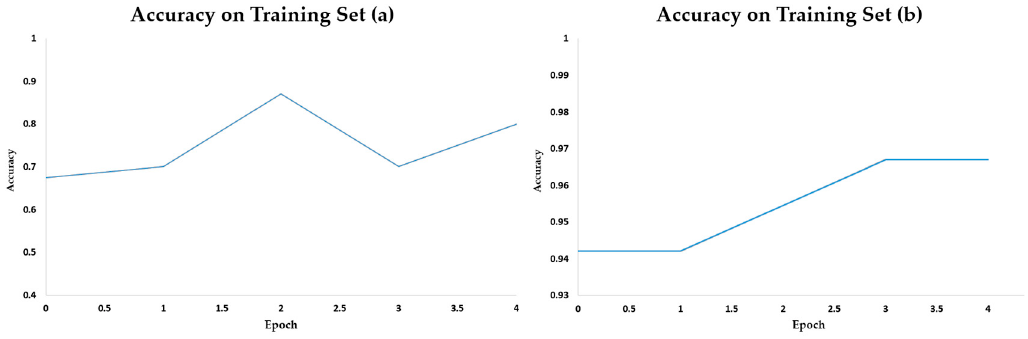
Figure 7. Level of accuracy during the training phase obtained on ( a , b ) DSB datasets.